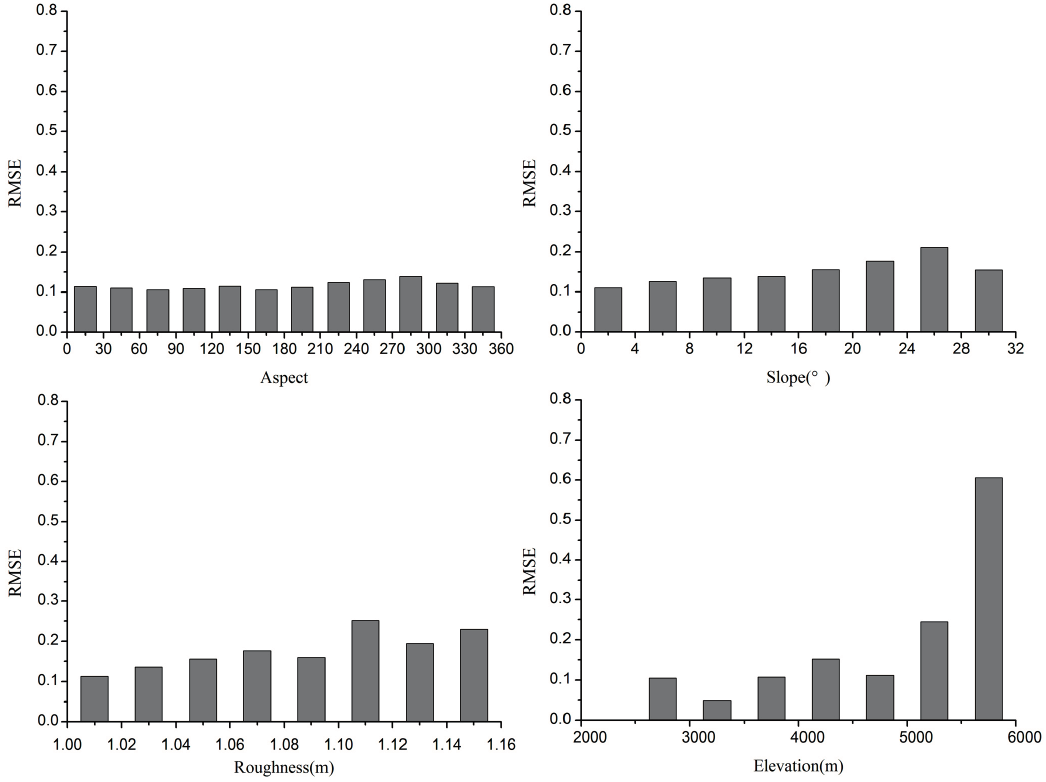
Figure 10. RMSE as a function of aspect, slope, roughness and elevation in croplands.